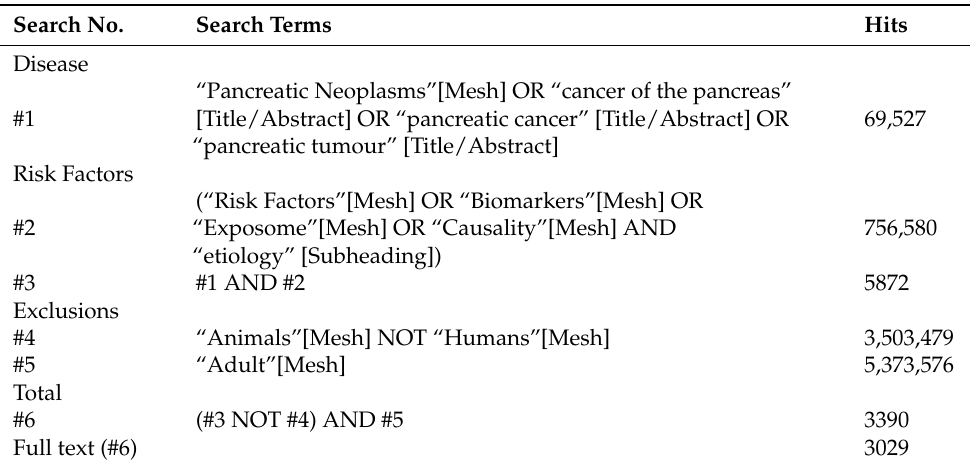
Table 1. Search Strategy followed in the Search engine Pubmed on 03/12/2020. Search